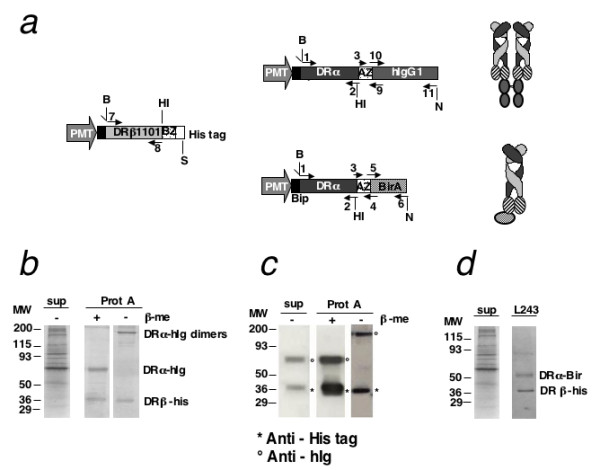
Construction of soluble recombinant HLA-DR*1101-Ig and HLA-DR*1101-Bir molecules. Structure and homogeneity of purified soluble HLA-DR*1101 recombinant molecules. (a) Schematic representation of HLA-DR*1101-Ig and HLA-DR*1101-Bir constructs. The extracellular region of HLA-DR*1101β is fused with the Basic Zipper (BZ) and His tag. The HLA-DRα chain is fused with the Acid Zipper (AZ) and the human (h)IgG1 constant region or the biotynilation site BirA, respectively. All constructs are cloned into the pMT/V5/His Drosophila expression vector, in frame with the Drosophila leader sequence Bip, under the control of a metallotioneine promoter, inducible by CuSO4 addition. The HLA-DR*1101-Ig molecule is secreted into the supernatant of Drosophila cells as dimer of HLA-DR*1101α/β heterodimers, because of a disulphide bond between two hIgG domains. (b) SDS-PAGE of HLA-DR*1101-Ig molecules secreted into the supernatant of S2 cells (sup) after CuSO4 induction, and after purification by protein A affinity chromatography (Prot A). Gels were run either in reducing (+βm) or non-reducing (-βm) conditions. Indicated are the bands corresponding to the migration of the HLA-DRα-hIg homodimers, HLA-DRα-hIg monomers and HLA-DR*1101β-His tag proteins. (c) Western blotting analysis of HLA-DR*1101-Ig molecules, separated on SDS-PAGE as shown in (b). The blotted filter was probed at the same time with the anti-His tag and anti-hIg probes, as indicated in figure. Empty circle and asterisk indicate the migration of the HLA-DRα-hIg and HLA-DR*1101β-His tag, respectively. (d) SDS-PAGE analysis of the HLA-DR*1101-Bir molecule contained into the supernatant (sup) of S2 cells after CuSO4 induction, and after purification by immunoaffinity chromatography with L243 mAb (L243).